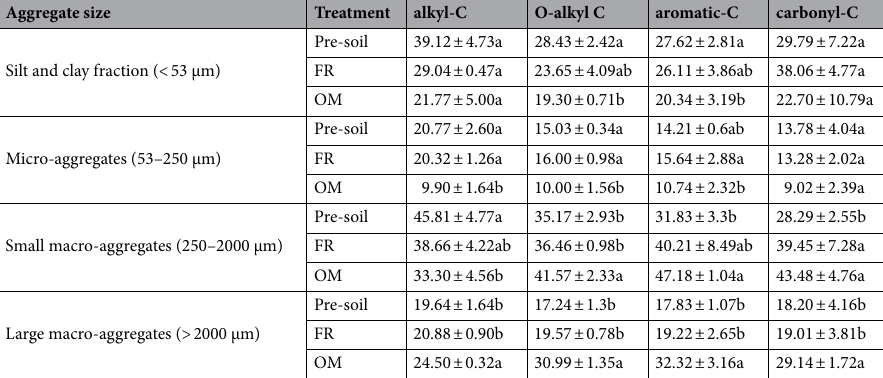
Table 1. Contribution of the aggregates associated C functional groups to 0-20 cm bulk soil in different treatments (%). The results show means ± standard deviations (n = 3). Different letters at the same columns indicate significant differences ( p < 0.05) between treatments. FR chemical fertilizer, OM organic manure.